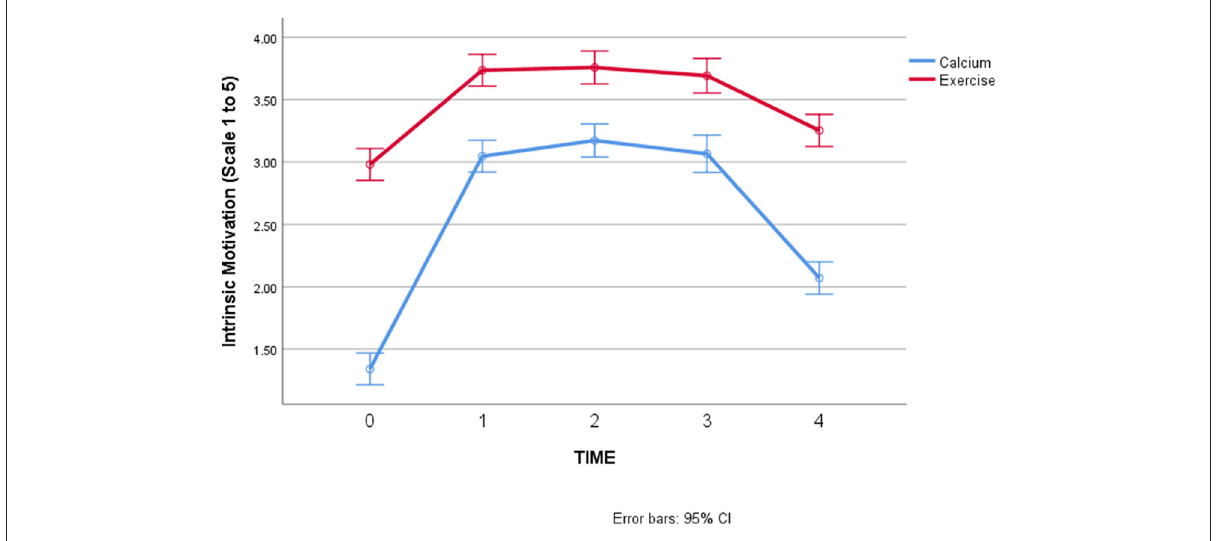
FIGURE1b Changes in intrinsic motivation over time, by behavior.